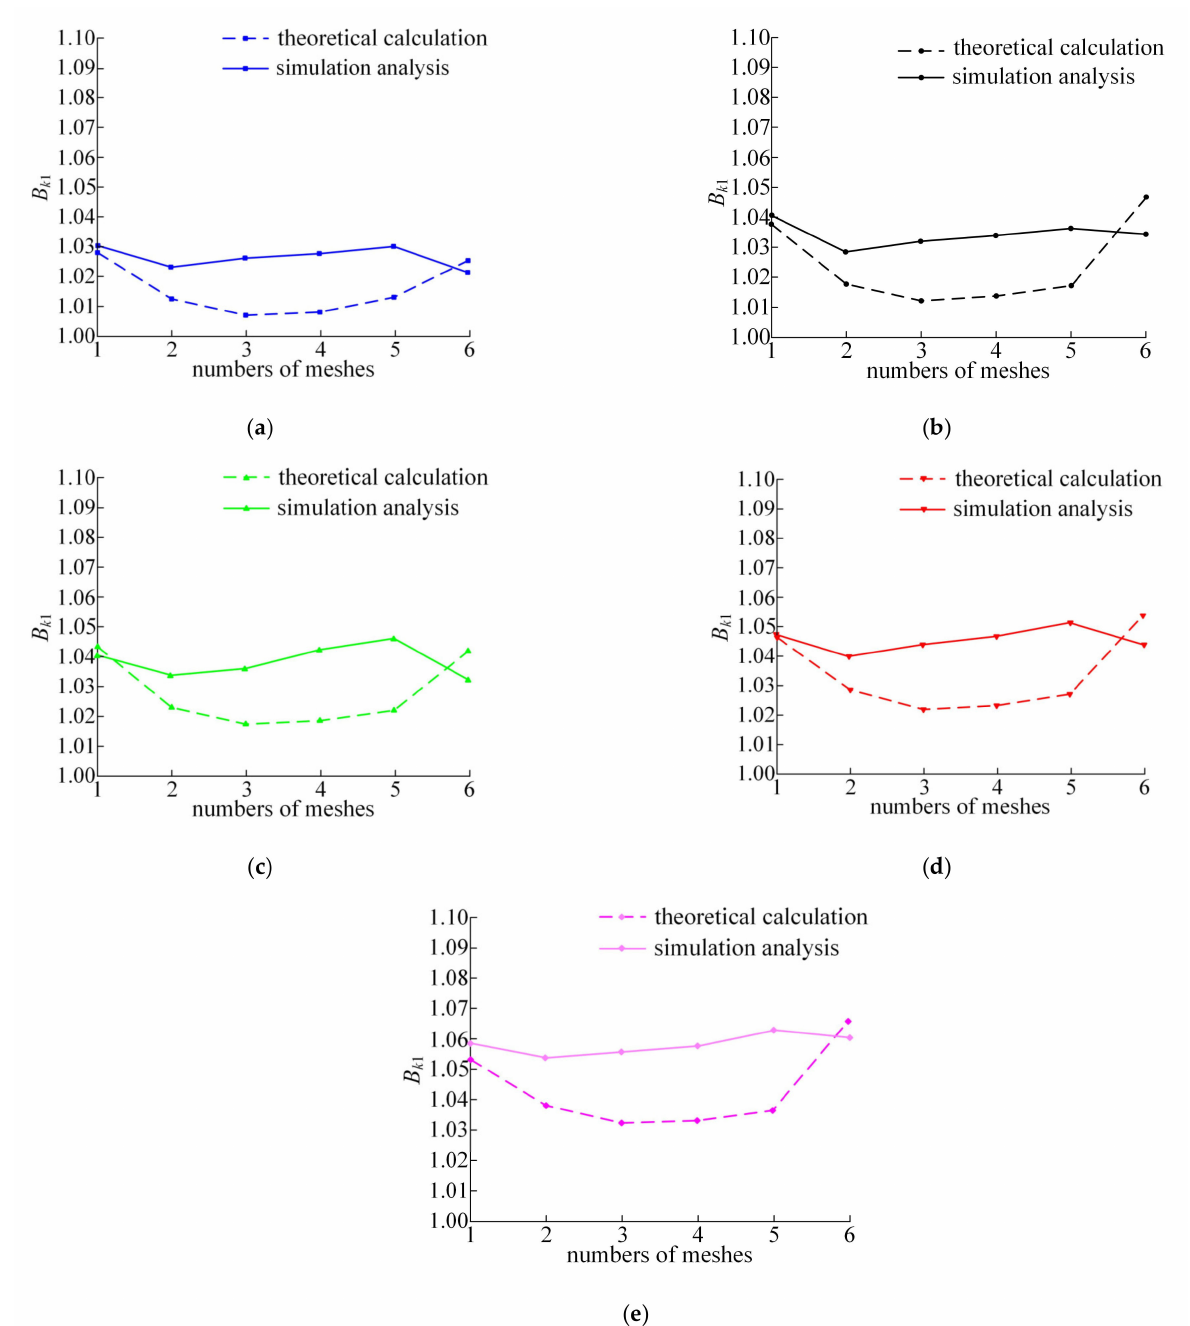
Figure 10. Comparison of load proportional coefficient curves at different input speeds: ( a ) 400 r/min; ( b ) 600 r/min; ( c ) 800 r/min; ( d ) 1000 r/min; ( e ) 1200